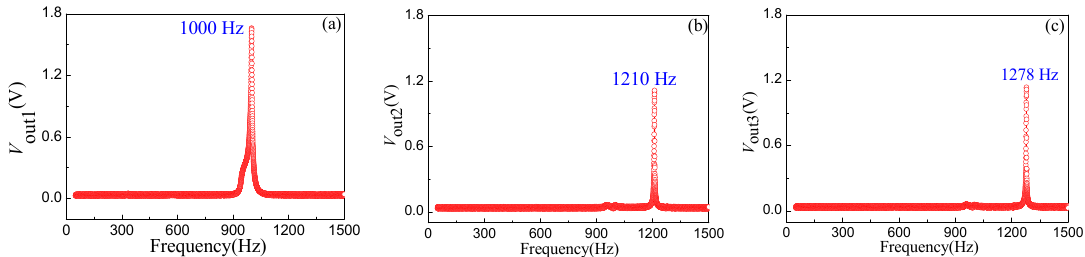
Figure 10. The vibration characteristics of the cantilever beam array: ( a ) the first beam; ( b ) the second beam; ( c ) the third beam.